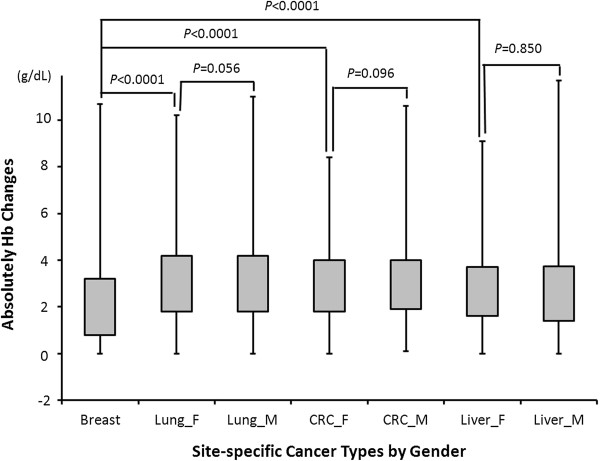
Hb changes in different cancer types by gender. Breast, breast cancer patients, Lung_F, female lung cancer patients; Lung_M, male lung cancer patients; CRC_F, female colorectal cancer patients; CRC_M, male colorectal cancer patients; Liver_F, female liver cancer patients; Liver_M, male liver cancer patients. The grey boxes were quartile range of absolutely Hb changes from 25-75%, the upper and lower error bars indicated maximum and minimum changed values of Hb, respectively. The indicated groups were compared by Student’s t test.